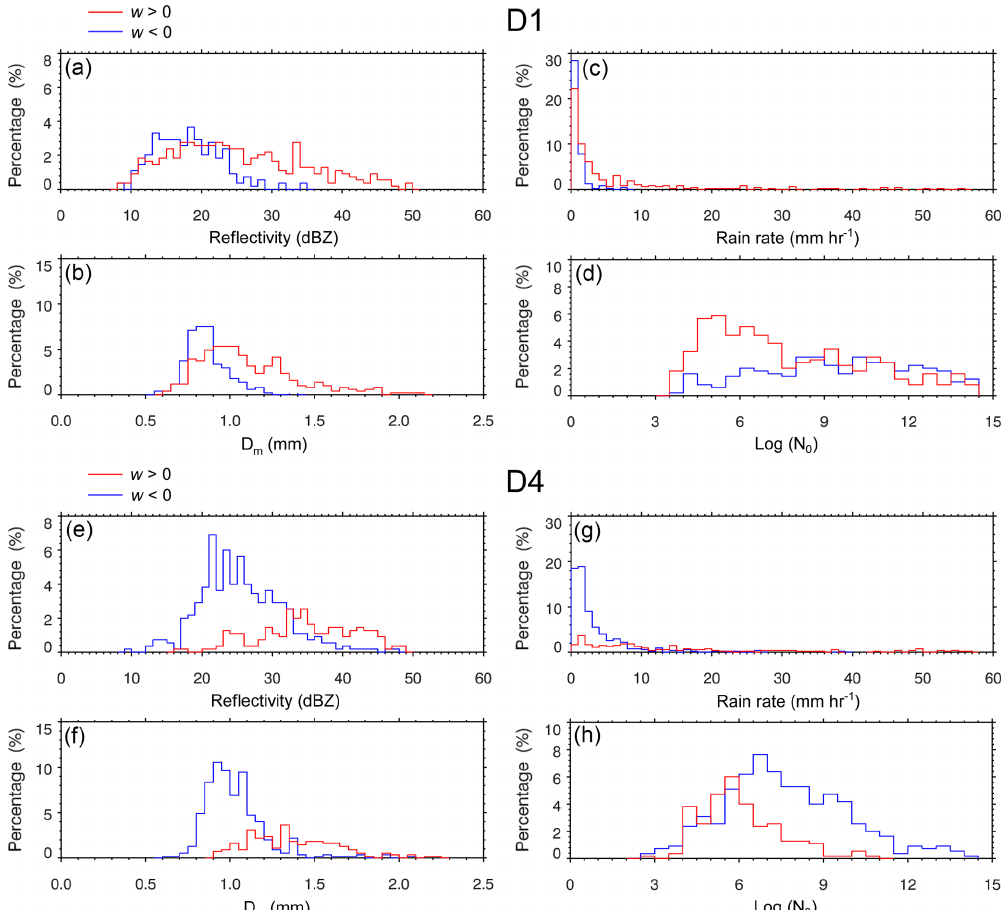
Figure 9. Frequency histograms of retrieved DSD parameters with regard to the upward (red line) and downward w (blue): (a) radar reflec- tivity (dBZ), (b) D m (mm), (c) rain rate (mmh − 1 ), and (d) N 0 (m − 3 mm − 1 − µ ) in log scale at D1 (top four panels) and same as these but for D4 (bottom four